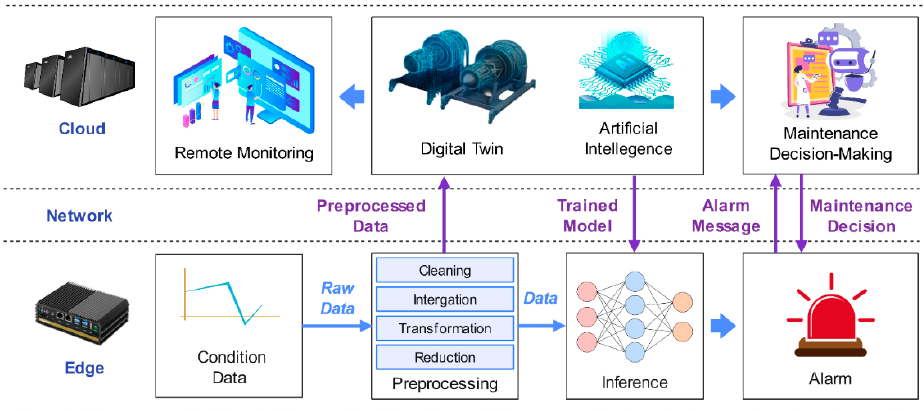
Figure 4. General edge intelligence architecture.